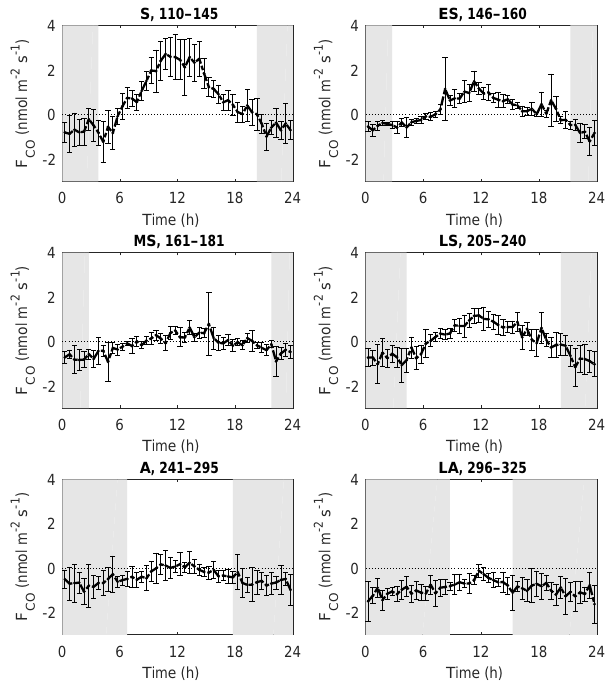
Figure 2. Diurnal cycle of half-hour mean CO fluxes ( F CO , nmolm − 2 s − 1 ) from the reed canary grass crop from six distinct periods during the April to November 2011. Grey areas indicate the moment of sunrise and sunset, and the vertical bars indicate ± 1 SD of the